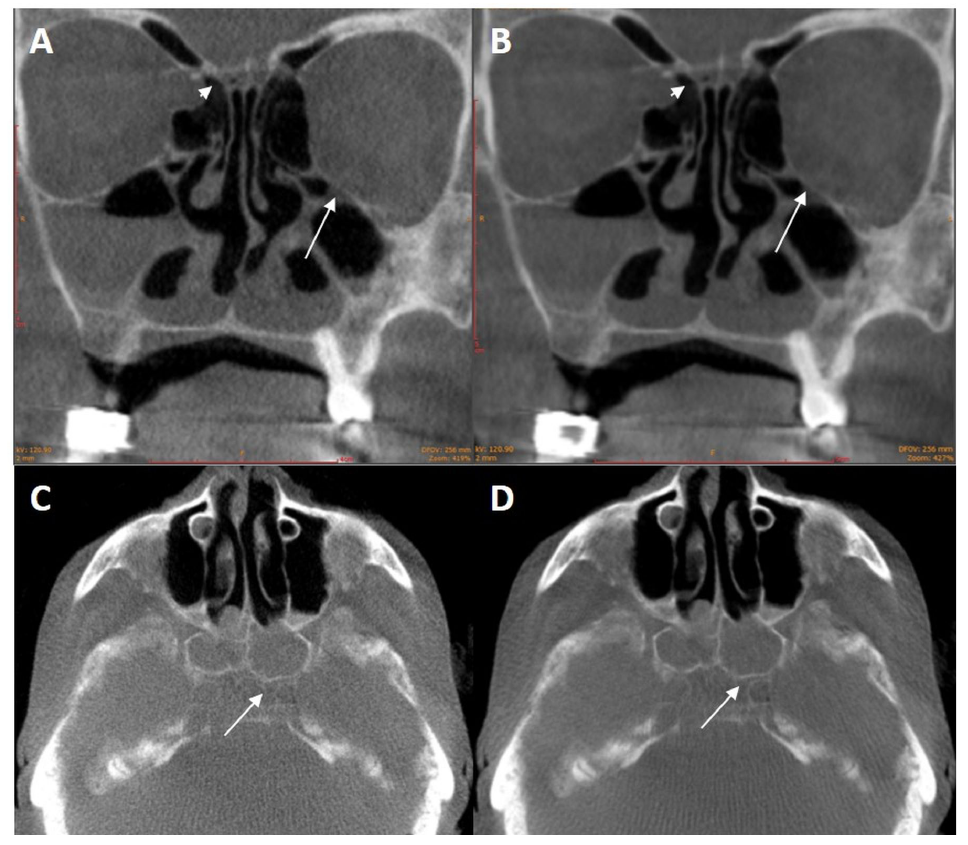
Figure 6. Difference between 121 kV/DL 278 ( A , C ) and 121 kV/DL 1090 ( B , D ). Note the better detail visibility of the bony structures in ( B ) (orbital floor: arrow; olfactory fossa: arrowhead) or in ( D ) (carotid canal: arrow).